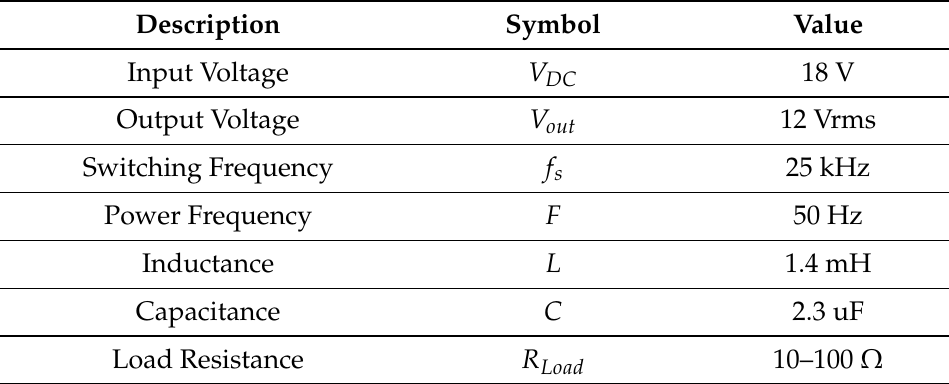
Table 3. Experimental parameters of